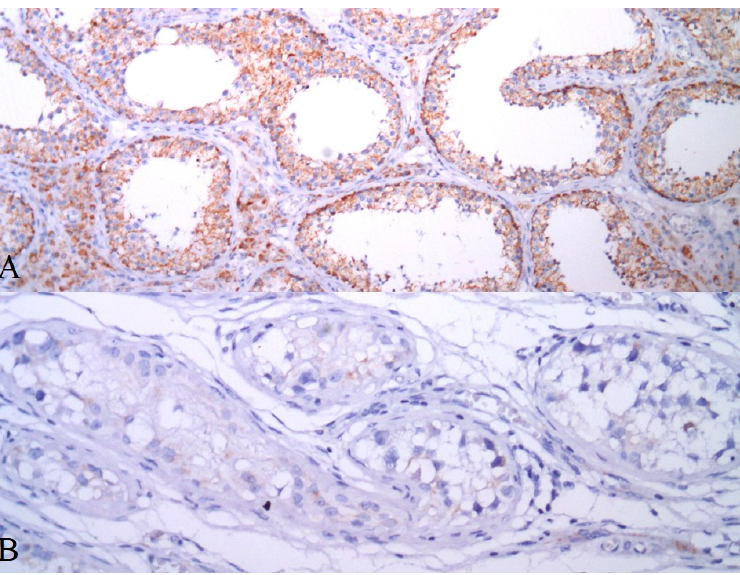
Figure 4. AIF expression (immunoperoxidase technique) in spermatogenic cells of noncancerous testicular tissue ( A , 100×) and in GCNIS ( B , 200×).